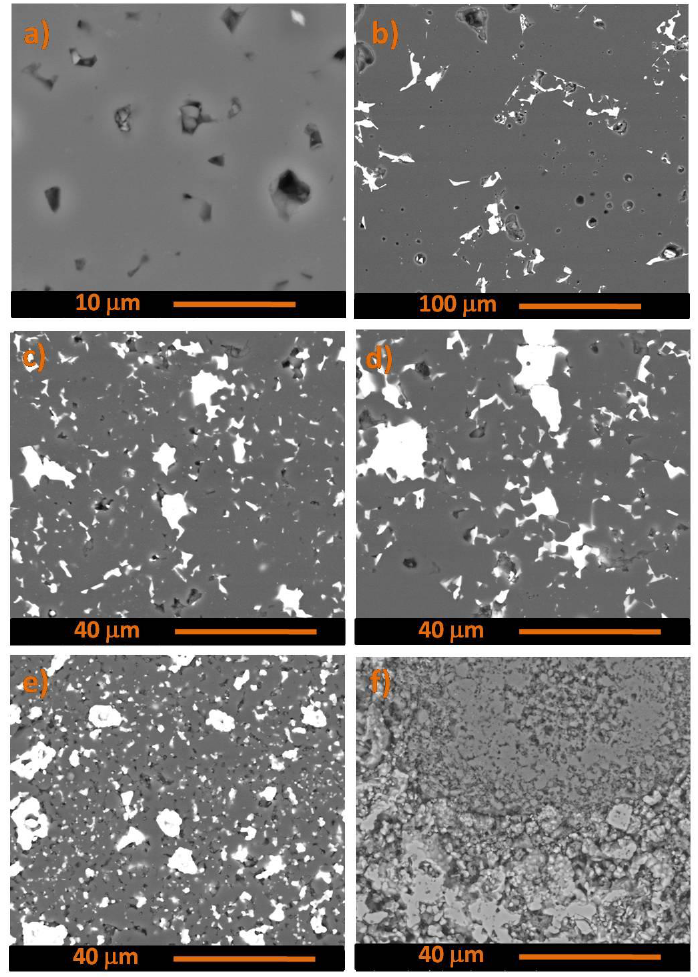
Figure 9. The SEM images showing the microstructures of the composites B 4 C: ( a ) 0% Ti 5 Si 3 , ( b ) 5% Ti 5 Si 3 , ( c ) 10% Ti 5 Si 3 , ( d ) 15% Ti 5 Si 3 , ( e ) 20% Ti 5 Si 3 , ( f ) stochiometric addition of Ti 5 Si 3 .